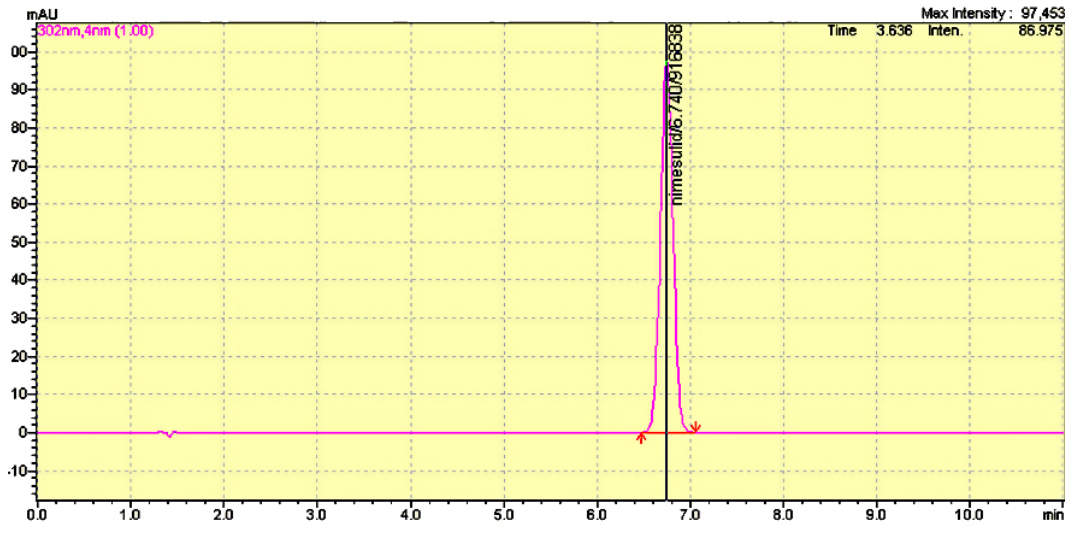
Figure 3. Chromatogram of